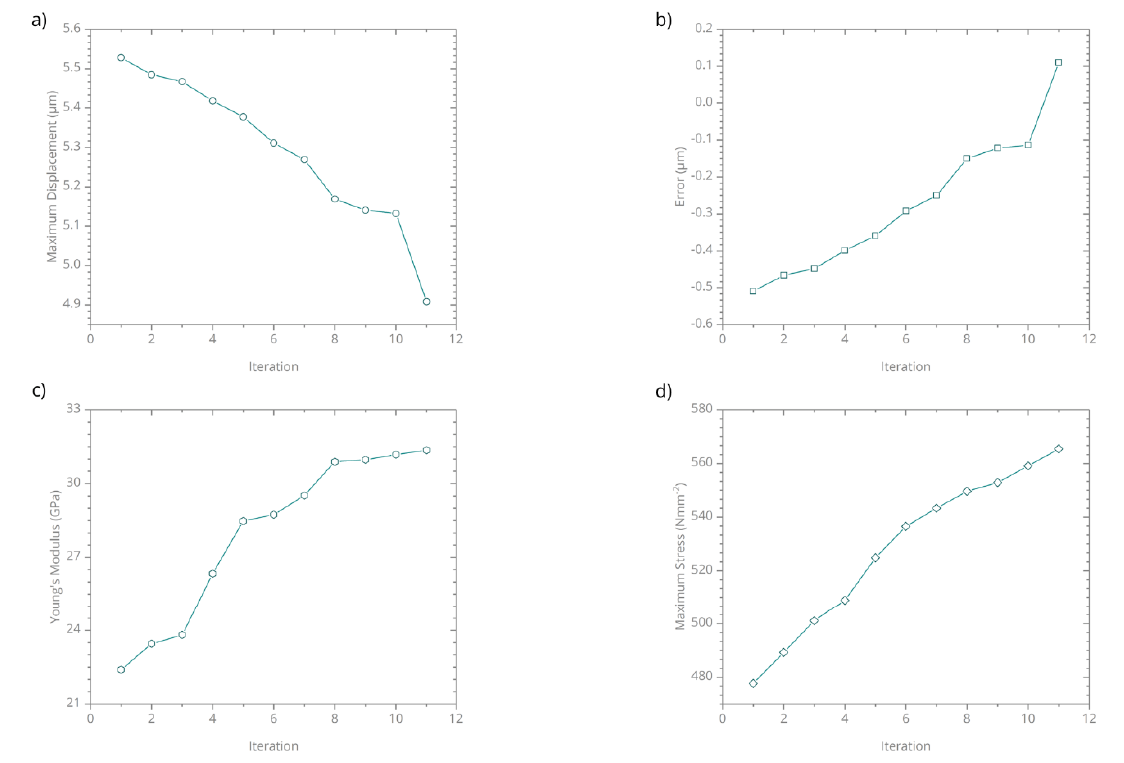
Figure 9. The iterative minimization of the deviation in the maximum displacement between the micro-indentation experiment and the simulation results: Iteration against ( a ) maximum displacement, ( b ) error, ( c ) Young’s modulus, ( d ) maximum stress at strain of 0.025. Nanomaterials 2020 , 10 , x FOR PEER REVIEW